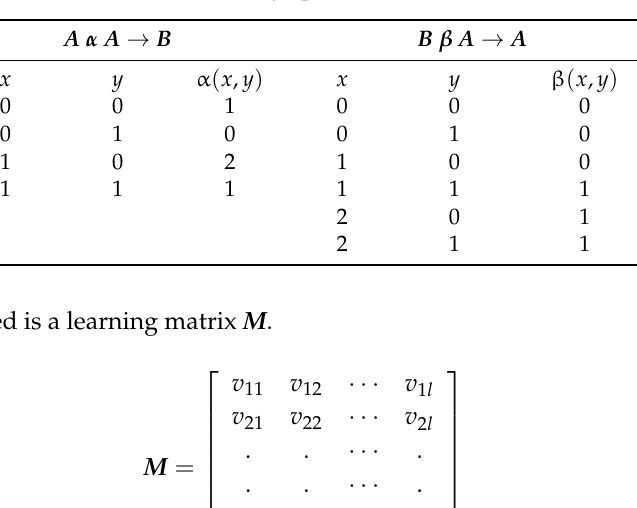
Figure 3. Learning phase of the Am αβ . Table 1. Binary operators α and β .